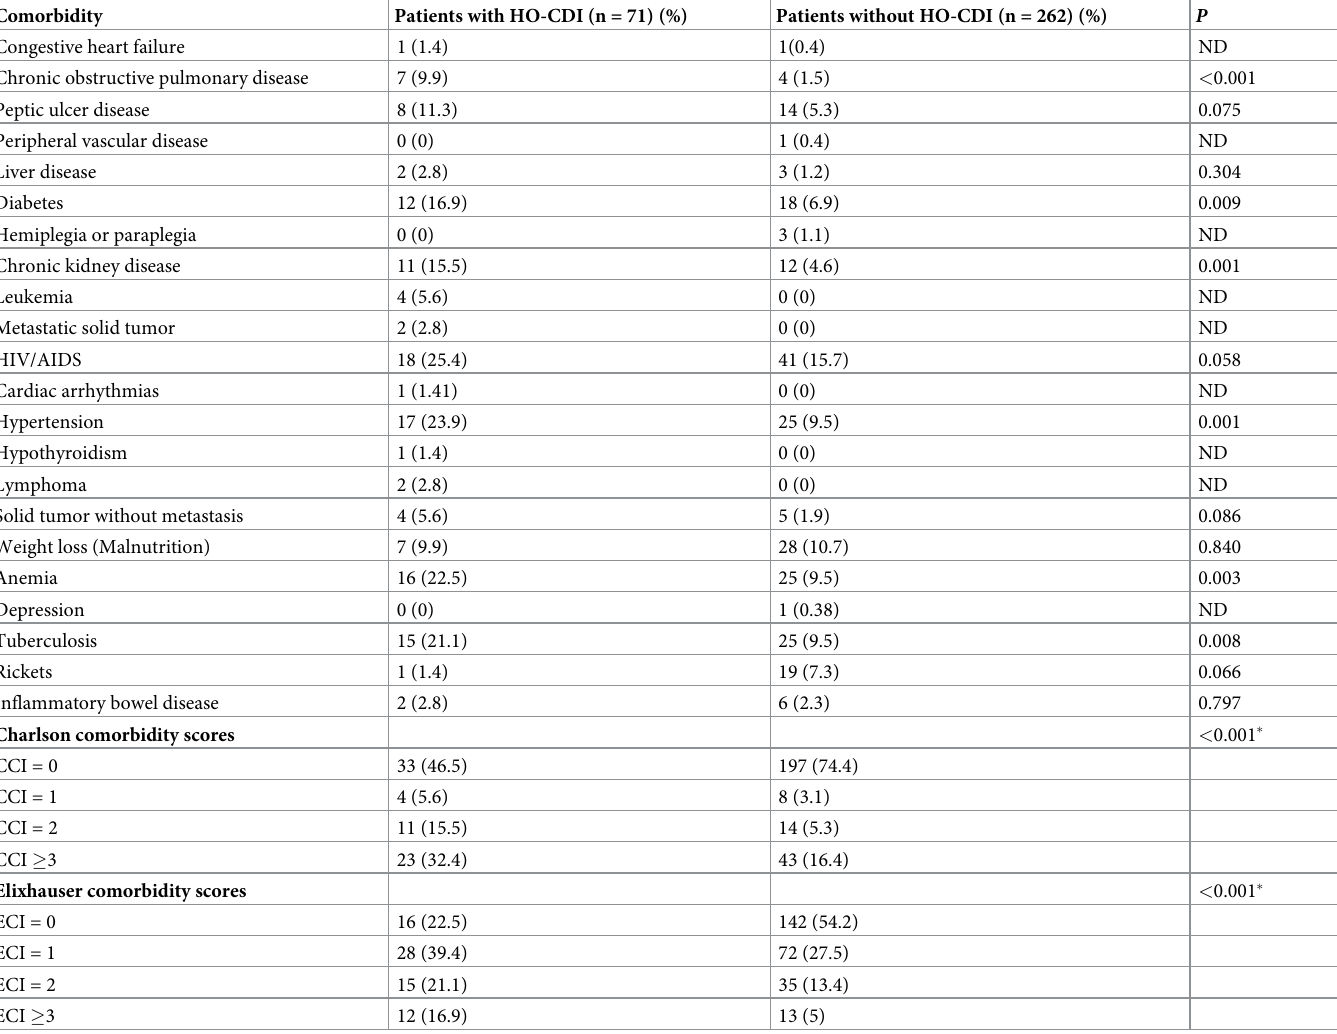
Table 2. Pairwise comparison of HO-CDI outcome to individual comorbidity conditions and comorbidity indices. Comorbidity Patients with HO-CDI (n = 71)